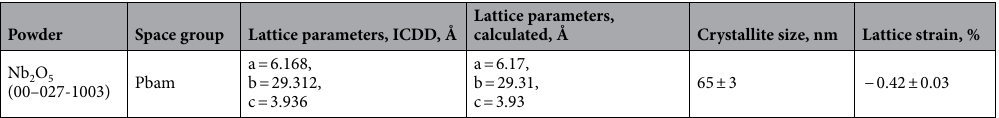
Lattice parameters, calculated, Å Crystallite size, nm Lattice strain, %